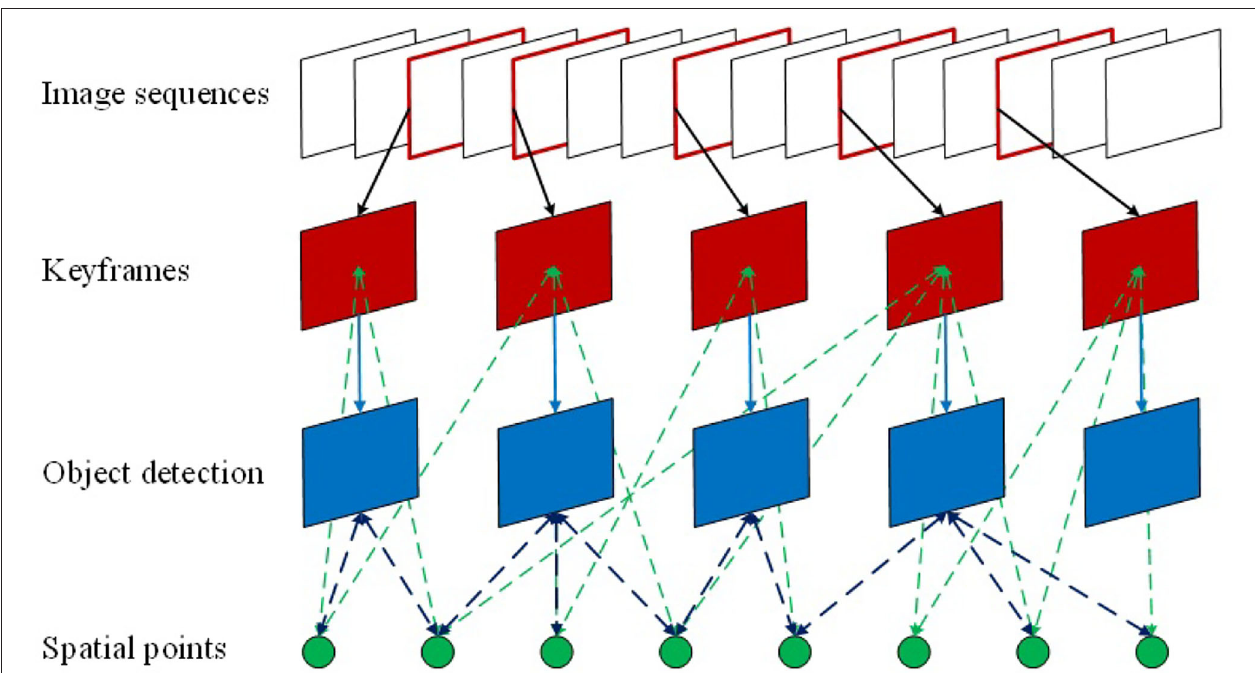
FIGURE 5 | The relationship between the object and spatial map